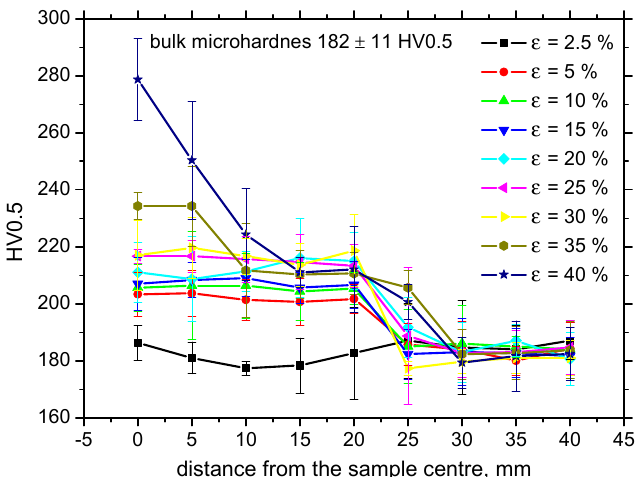
Figure 7. Evolution of microhardness along the sample length as a function of ε .